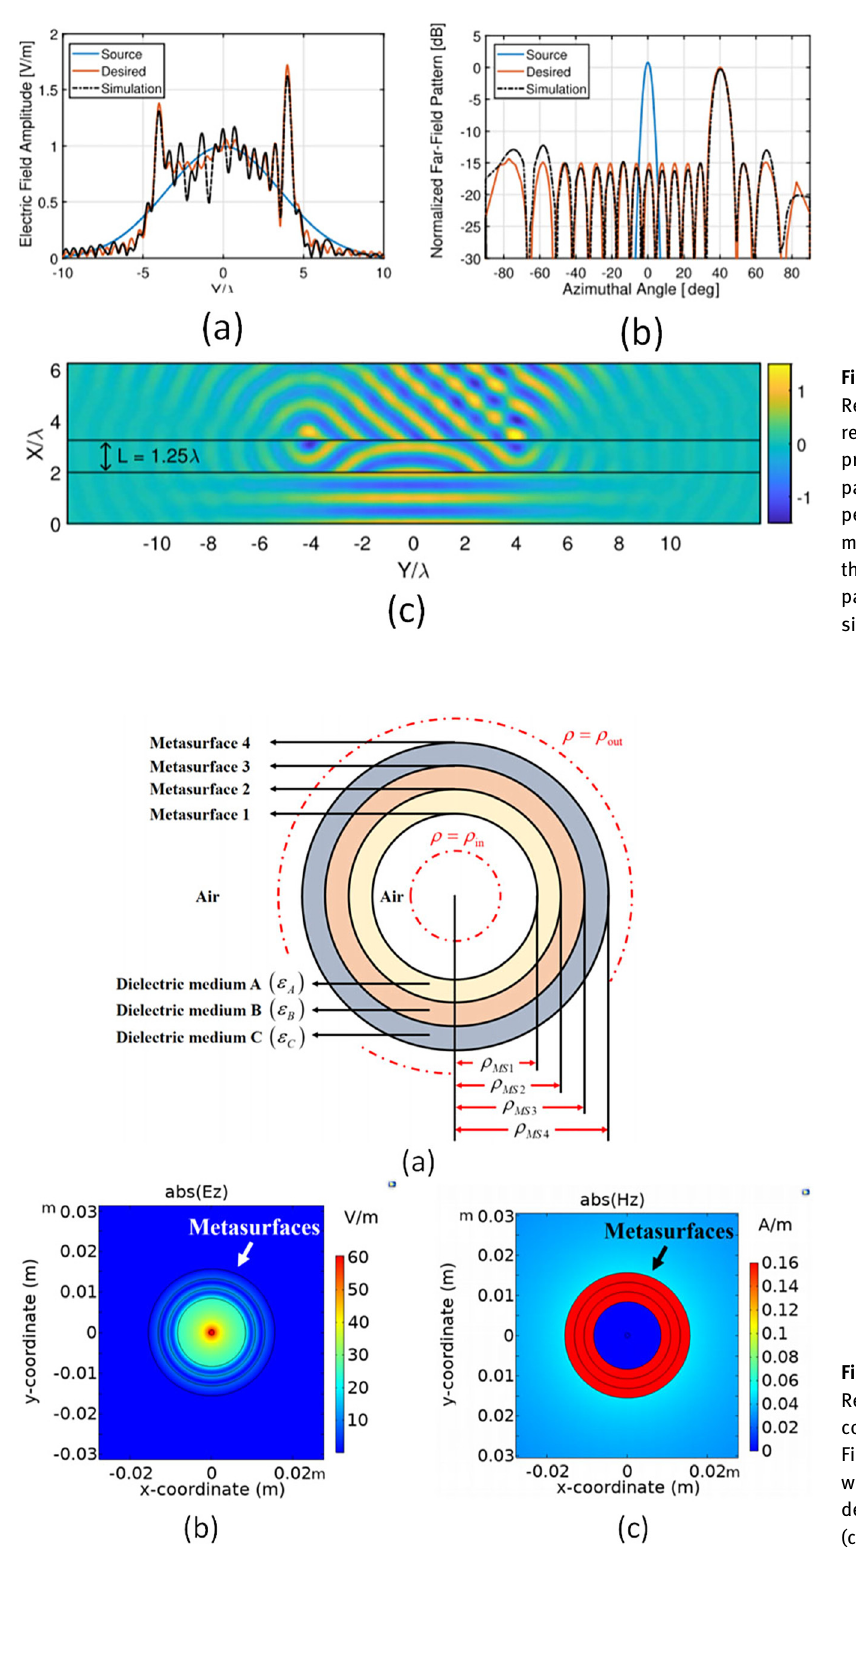
Figure 26: (Reprinted with permission from Ref. [107]). (a) Schematic of cascaded conformal cylindrical metasurface. (b – c) Field plots of the polarization converter when excited by an electric surface current densitynearthecenter.(b)Amplitudeof E z . (c) Amplitude of H z .